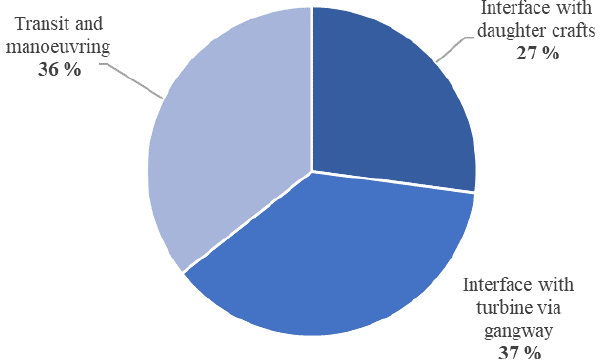
Figure 6. System variability for the three stage of SOV